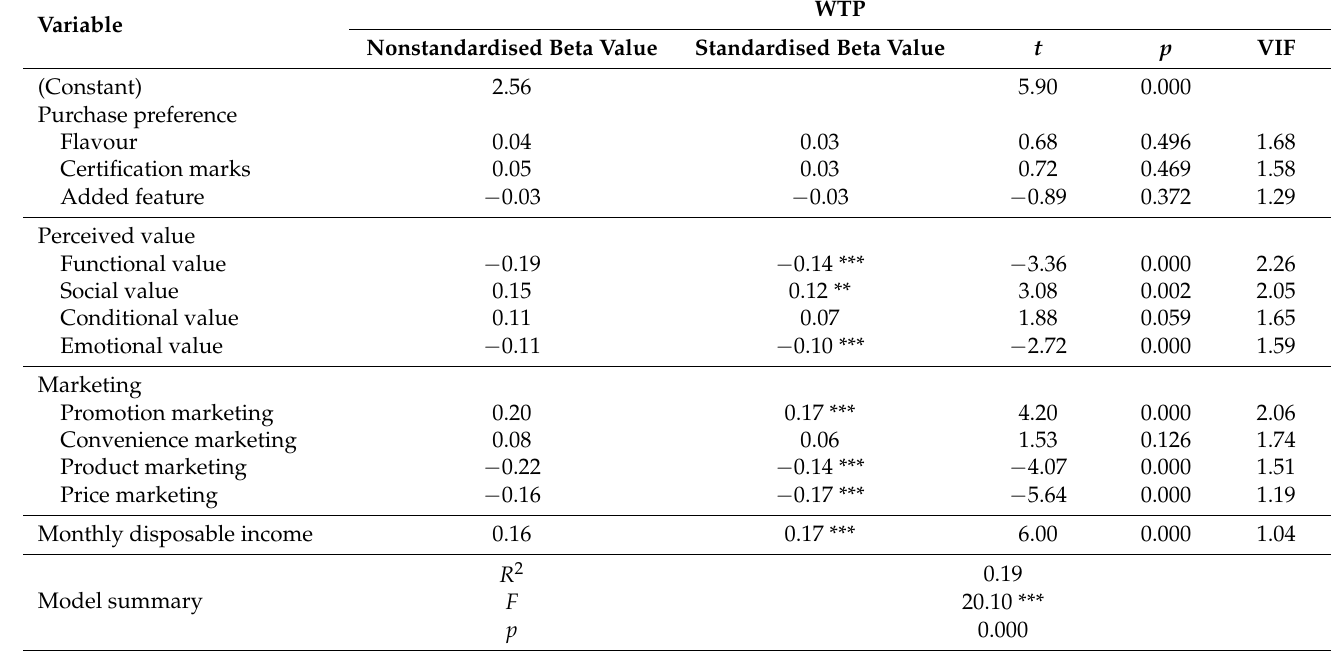
Table 4. Regression analysis of WTP ( n =